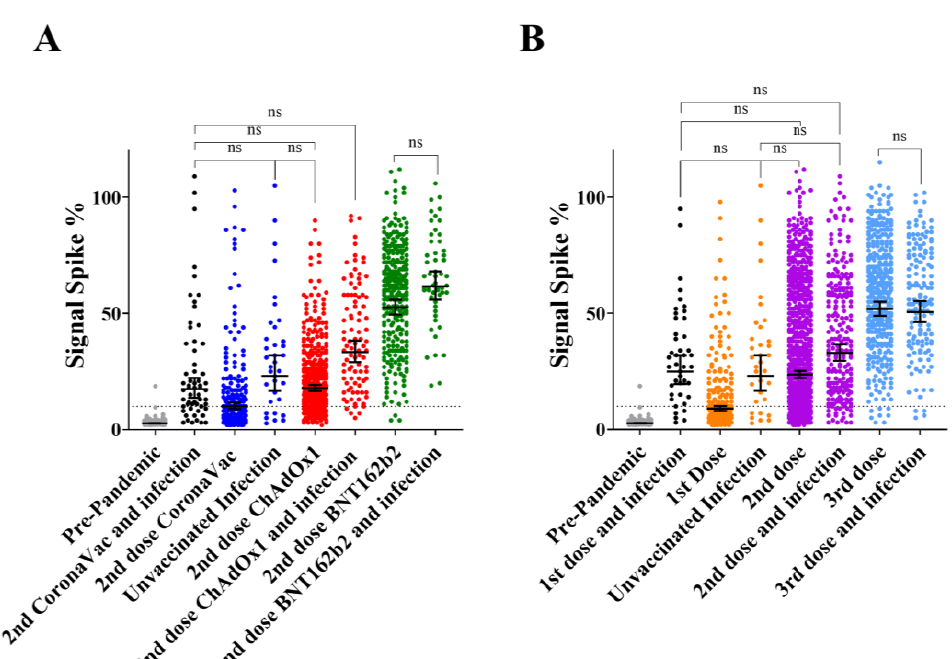
Figure 3. The levels of IgG reactive to spike protein in response to infection and vaccination. ( A ) Participants that completed the primary vaccination (2nd dose) were grouped accordingly to the vaccine type. Those participants who self-declared a previous positive COVID-19 test are indicated as infection cases. ( B ) Participants were grouped accordingly to the number of vaccine doses. The dashed line indicates the seropositive assay cutoff. Pre-pandemic samples were plotted as naïve controls. Bars represent the geometric mean and 95% CI. One-way ANOVA analysis was performed, and comparisons were all significant ( p < 0.02) unless indicated as not significant (ns).